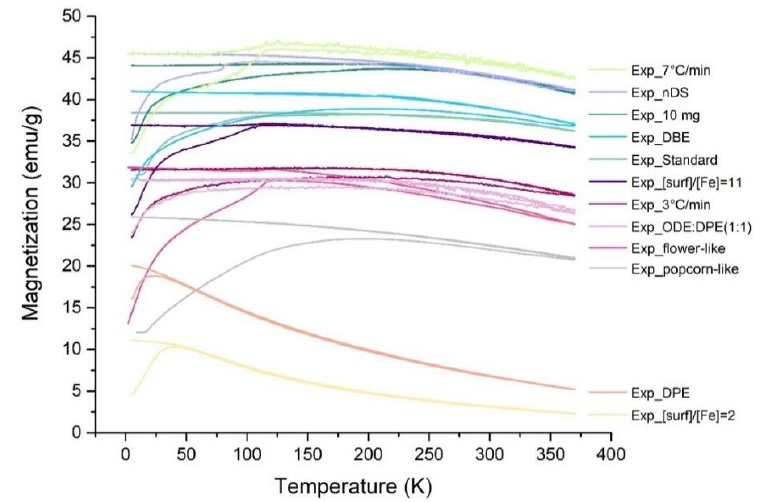
Figure 4. ZFC/FC-curves of the Pd/Fe-oxide NPs samples (abbreviations explained in Table 1) measured at 1 kOe.